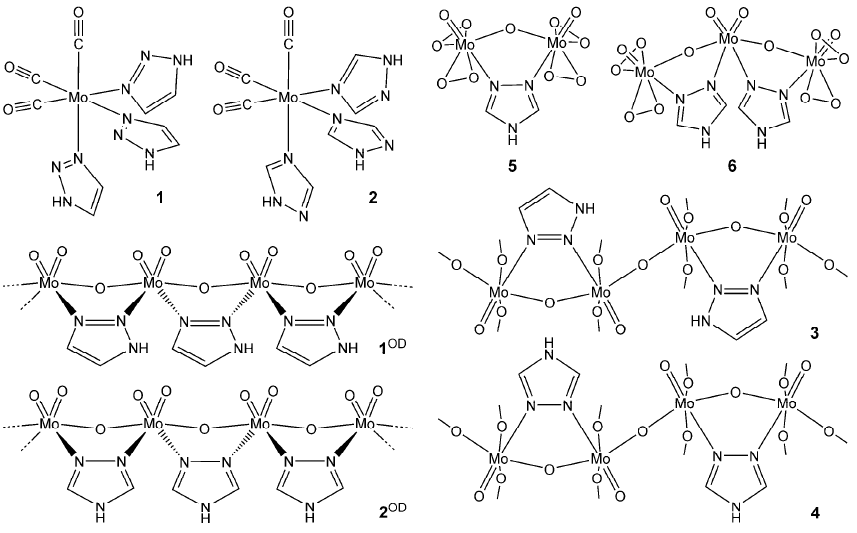
Figure 2. Schematic representations of the proposed structures for 1 , 2 , 1 OD and 2 OD , and the known structures for 3 – 6 .